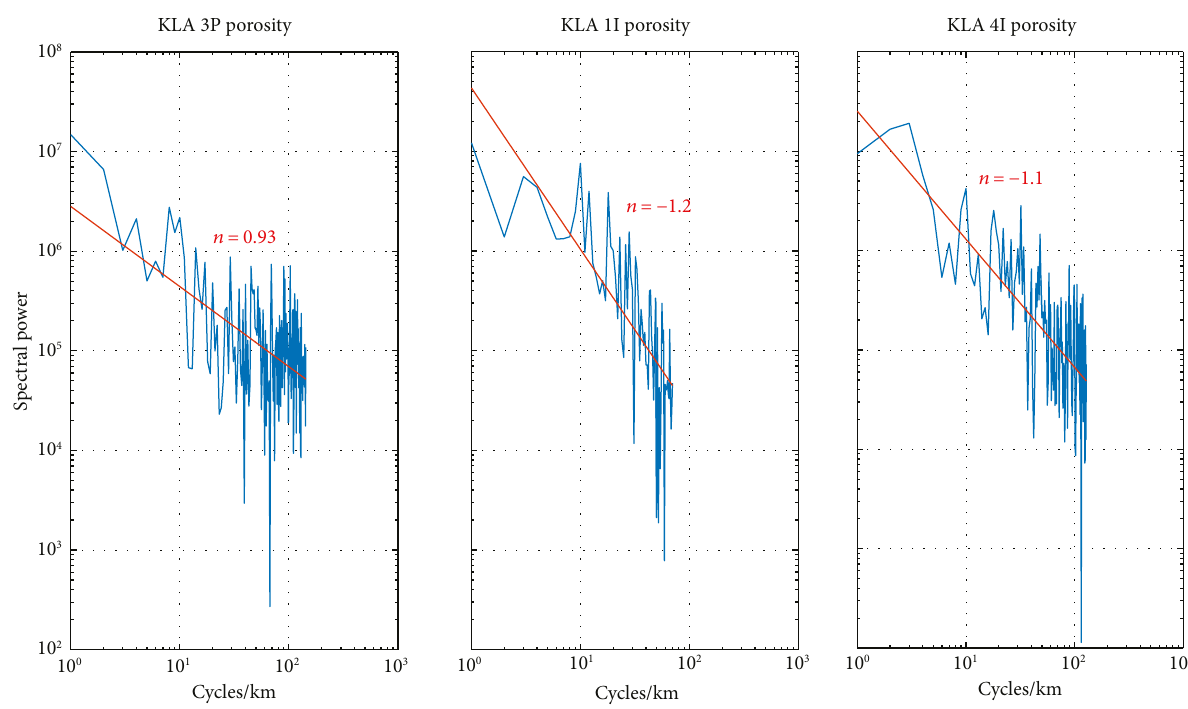
Figure 4: Fourier power spectra of porosity well logs for Klaipeda wells 3P, 1I, and